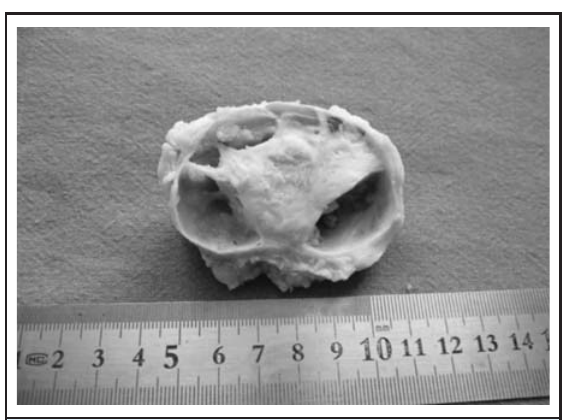
Figure 1. Gross photograph showing solid and cystic areas.